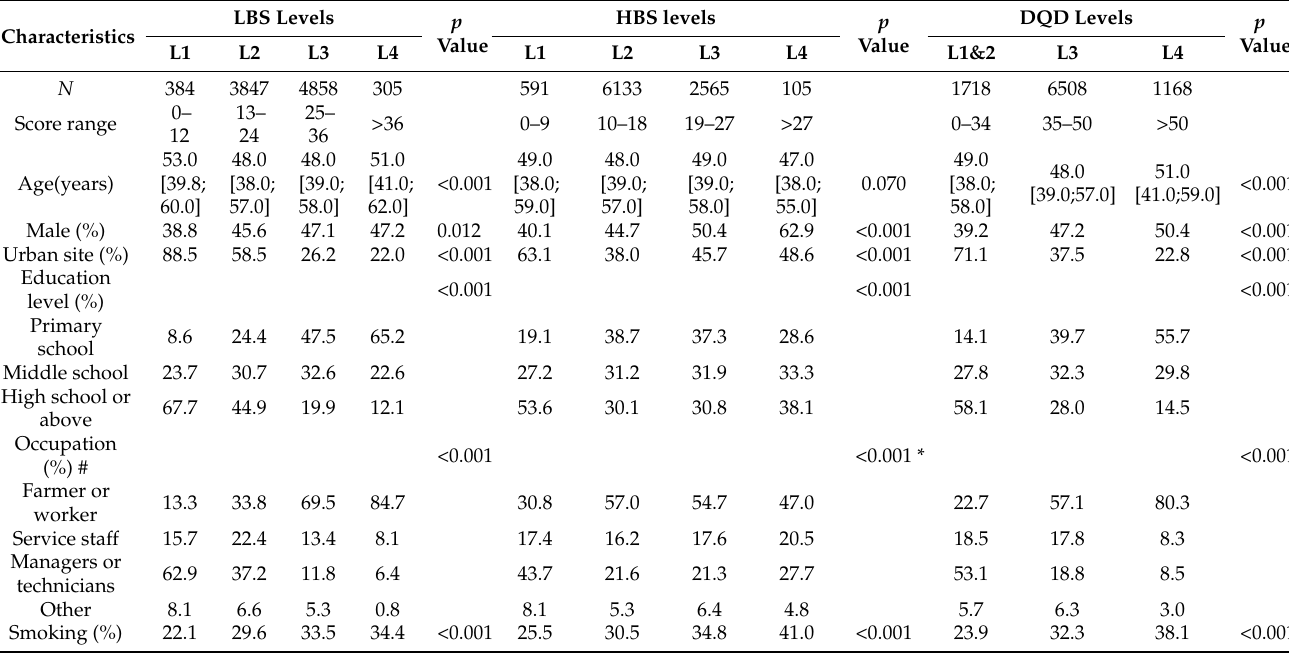
Table 2. Baseline characteristics of the participants on the different LBS, HBS, DQD levels ( N =